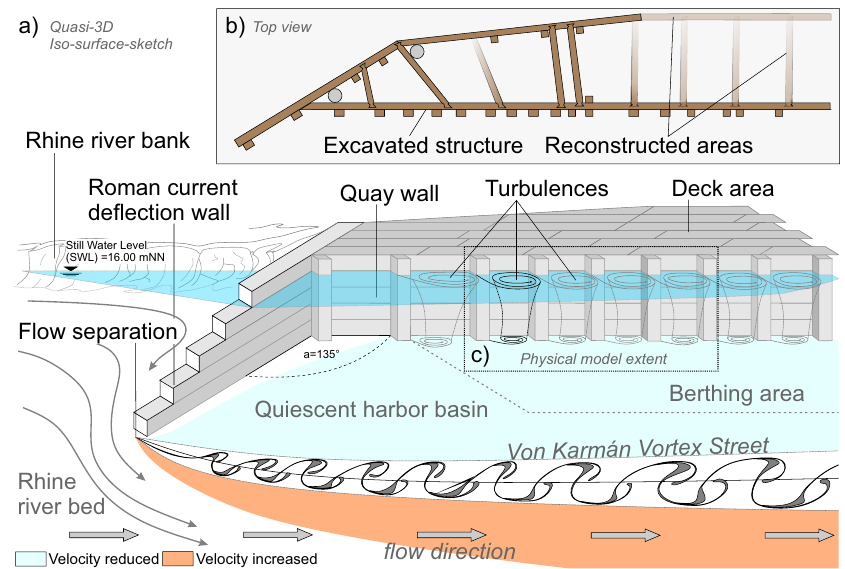
Figure 1. ( a ) Quasi-3D isometric sketch of the tip of the hydraulic structure (not to scale) with various associated hydrodynamic processes and the still water level (SWL); ( b ) Top view of the excavated structure (opaque) with extrapolated segments (transparent); ( c ) Quay-wall segment physically simulated in the hydraulic laboratory for determining roughness induced losses for numeric